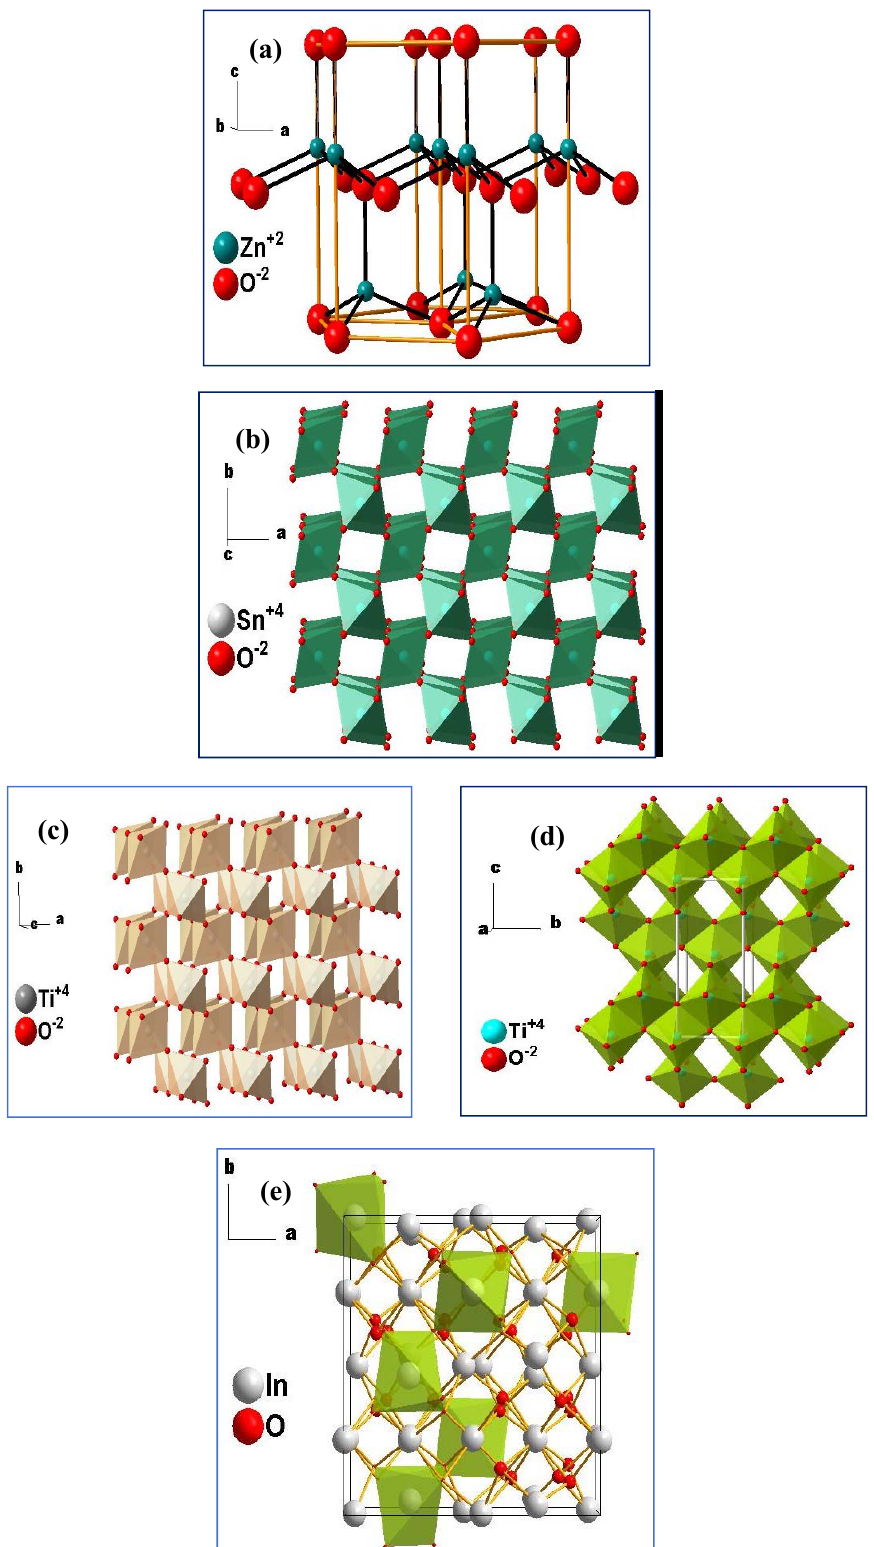
Figure 1. Crystal structures of ( a ) ZnO (wurtzite), ( b ) SnO 2 (rutile),( c ) TiO 2 (rutile), ( d )TiO 2 (anatase) and ( e ) In 2 O 3 (bixbyite).